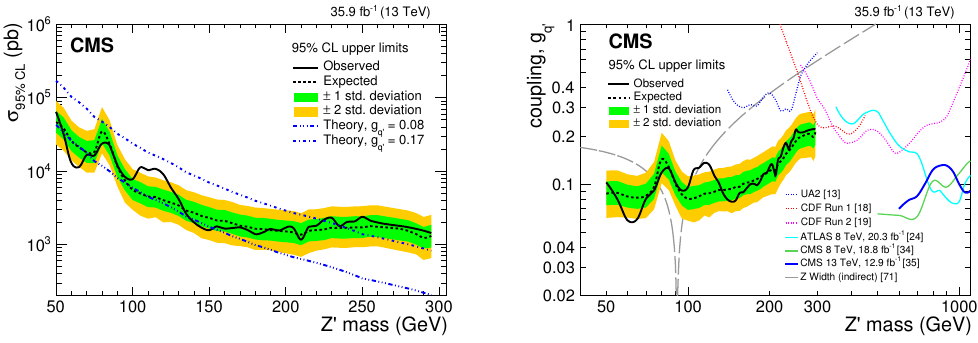
Figure 7 . The 95% CL upper limits on the Z 0 boson production cross section compared to theoretical cross sections (left) and on the quark coupling g q 0 as a function of resonance mass for a leptophobic Z 0 resonance that only couples to quarks (right). The observed limits (solid), expected limits (dashed) and their variation at the 1 and 2 standard deviation levels (shaded bands) are shown. Limits from other relevant searches and an indirect constraint on a potential Z 0 signal from the SM Z boson width [72] are also shown.